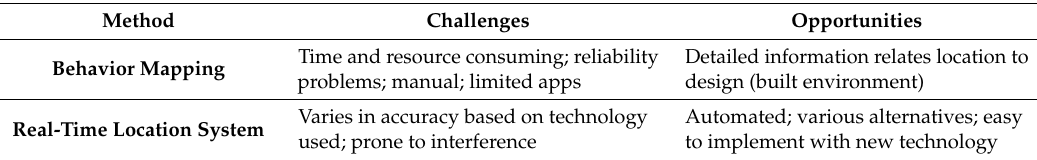
Table 1. Comparison of behavior mapping (BM) and real-time location systems